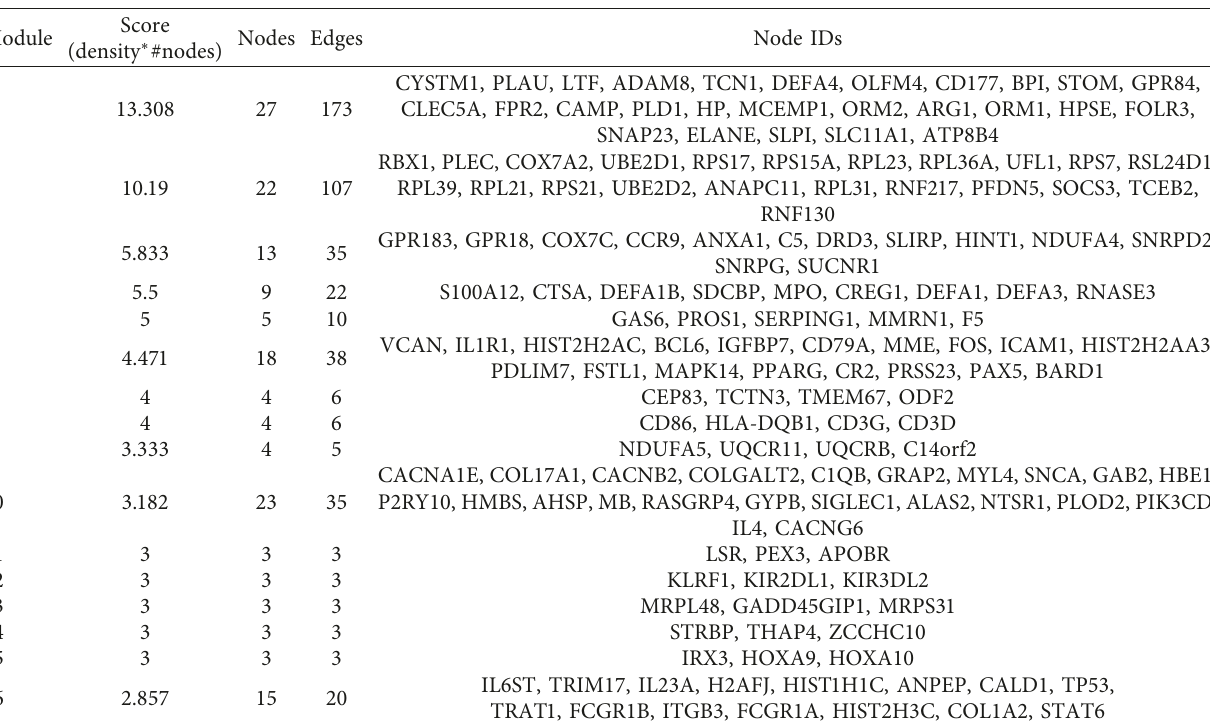
Table 4: The module analysis results with MCODE of the PPI network of